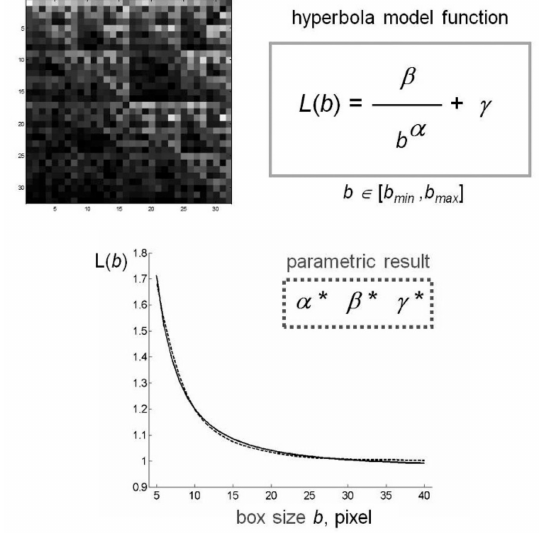
Figure 4. Schematic representation of fractal lacunarity analysis. (Top left) rCRS mtDNA image generated by CGR matrix for L = 5 is a 32x32 square. The plot (bottom) represents the result of GBA application (dotted line), for bmin = 3, as fitted by hyperbola function (solid line) used to calculate the triplet of parameters α , β , γ . CGR: Chaos Game Representation; rCRS: revised Cambridge Reference Sequence; GBA: Gliding Box